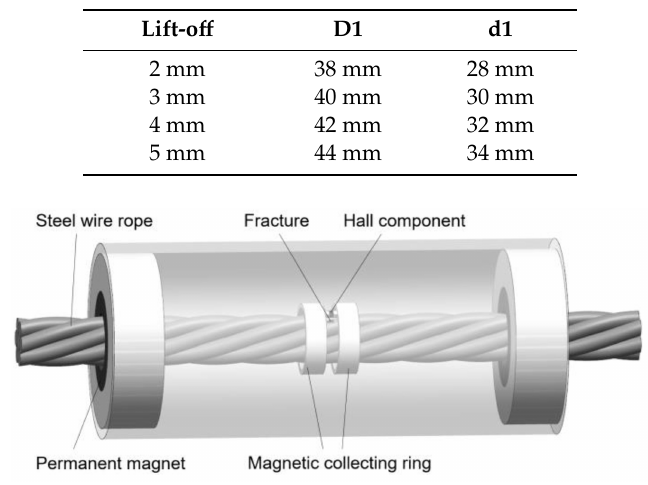
Table 1. Outer diameter and inner diameter of the magnetic ring under di ff erent lift-o ff .